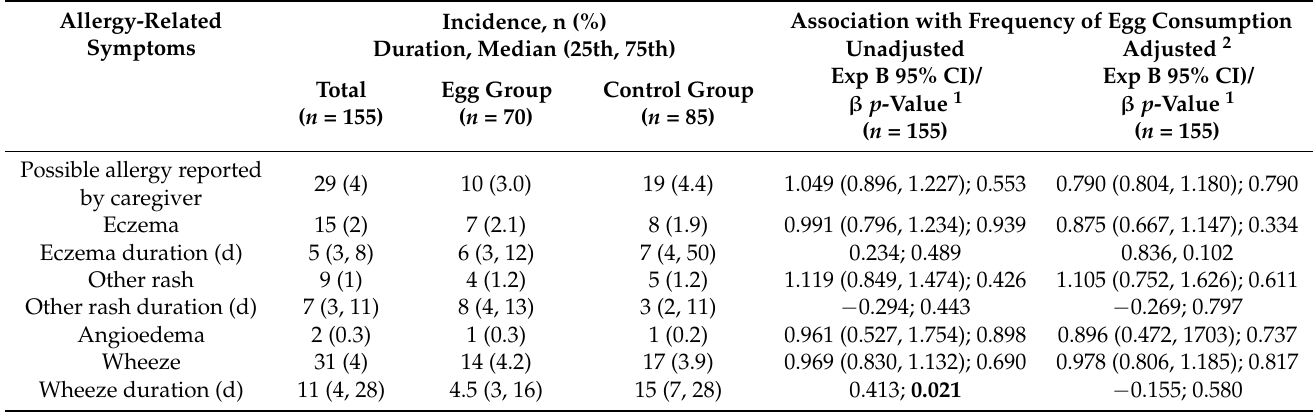
Table 9. Frequency of egg intake in relation to incidence and duration of allergy-related symptoms of babies during the 8-month intervention 1